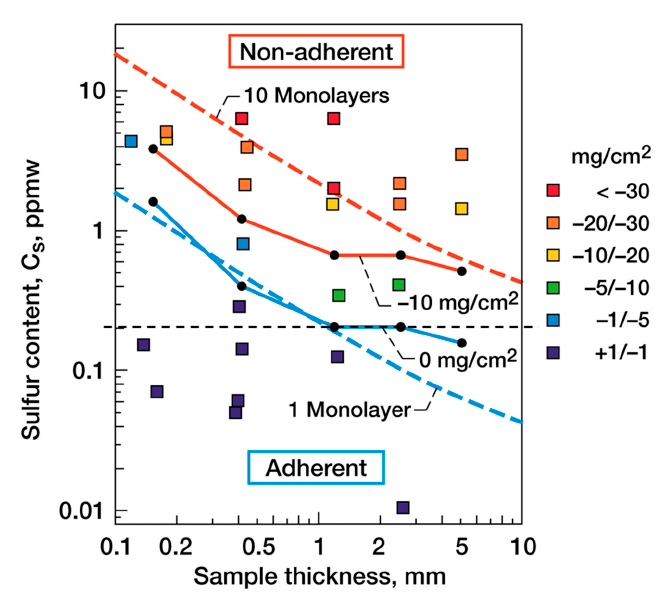
Figure 3. Cyclic oxidation adherence map for PWA 1480 [4] (1100 °C, 500 (1 h) cycles). Color coding indicates a trend to excellent performance (low weight change) for low sulfur samples and low thickness. Interpolated transition boundary (blue) correlates with a bulk sulfur reservoir equivalent to ~1 monolayer of total sulfur segregation. Projected McLean 1% surface coverage corresponds to 0.2 ppmw S bulk.